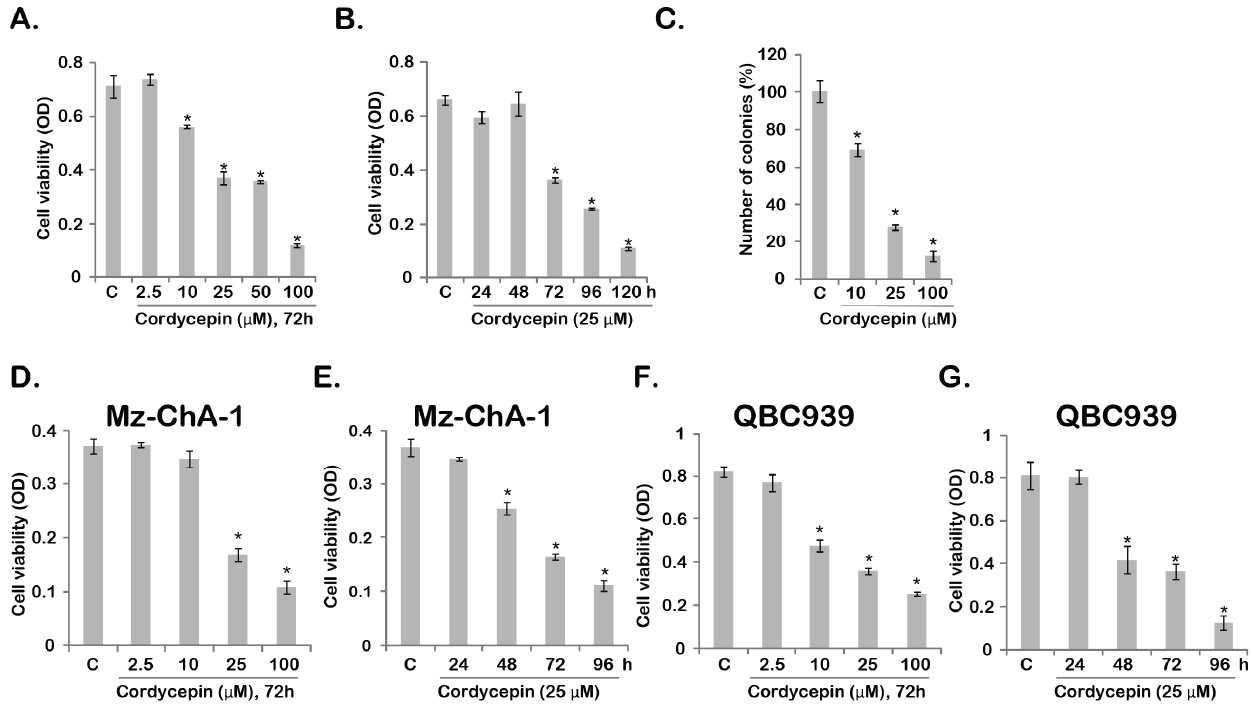
Figure 1. Cordycepin inhibits gallbladder cancer (GBC-SD) cell survival. The viability of GBC-SD cell ( A , B ) after indicated cordycepin treatment was tested by MTT assay. GBC-SD cells were cultured in cordycepin-containing medium for 10 days, the number of surviving colonies was recorded ( C ); The viability of Mz-ChA-1 ( D , E ) or QBC-939 ( F , G ) after indicated cordycepin treatment was tested by MTT assay. * Stands for p < 0.05 vs. control (“C”)